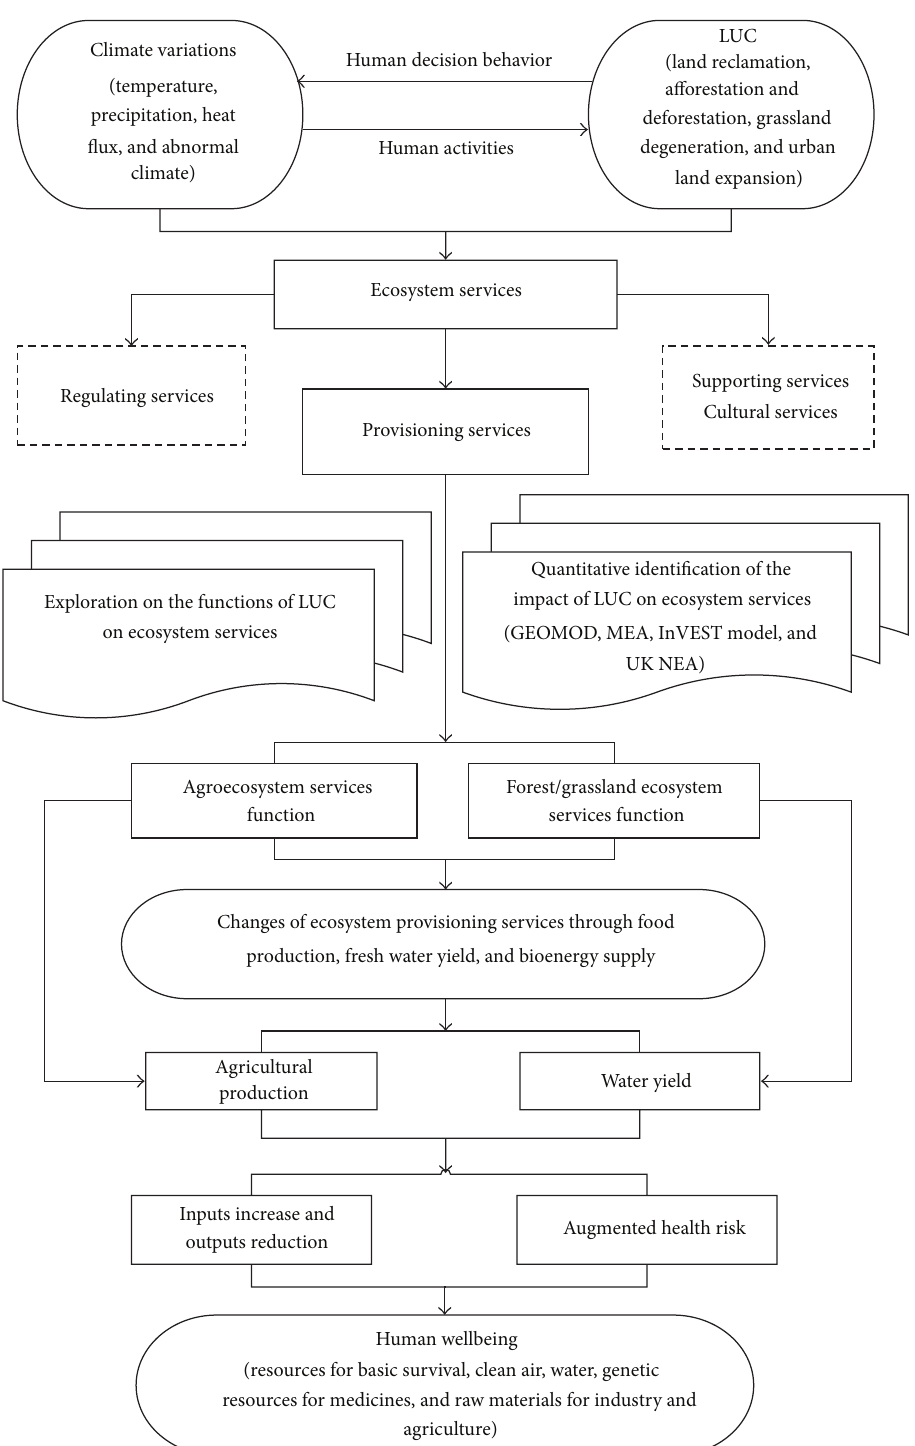
Figure 1: Diagram to trace the impacts of LUC and climate variations on the human wellbeing via altering the ecosystem provisioning